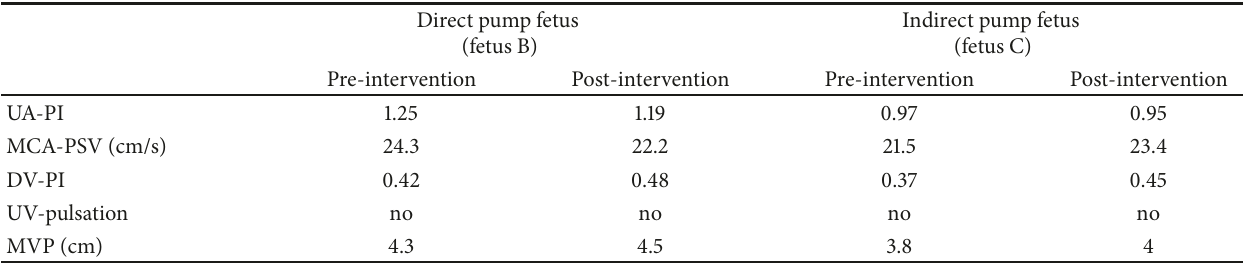
Table 1: Blood flow changes of the direct pump fetus and the indirect pump fetus around RFA.